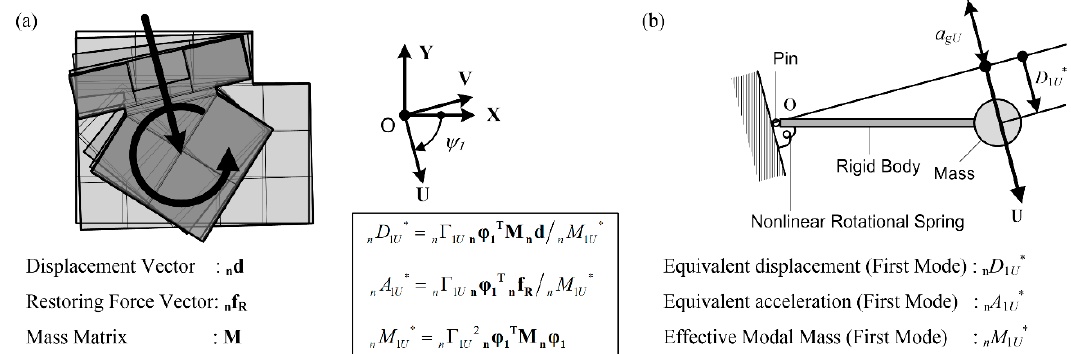
Figure 2. Comparisons of parameters between an N -story irregular building and the equivalent SDOF model: ( a ) an N -story irregular building deformed similar to the first mode shape and ( b ) equivalent SDOF model representing the first modal response.